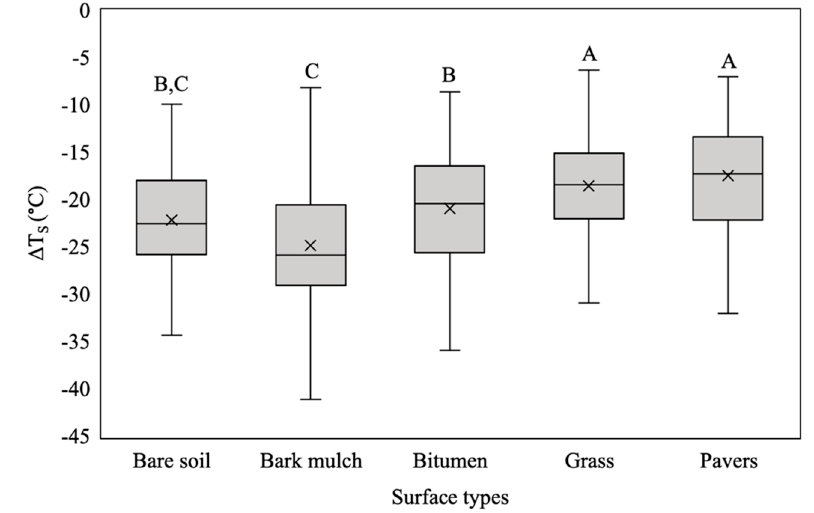
Figure 5. Box whisker plot illustrates the distribution of surface temperature differential ( Δ T S ) in surface types: bare soil, bark mulch, bitumen, grass and pavers. Levels not connected by the same letter are significantly different. The lower and upper line of the box shows the first and third quartile; the line and cross inside the box show the median and mean; the whiskers show minimum and maximum values. Table 3. Tukey’s HSD pairwise comparison of the surface temperature differential ( Δ T S ) and black globe temperature differential ( Δ T G ) observed among the five surface types: concrete pavers, grass, bitumen, bark mulch and bare soil.